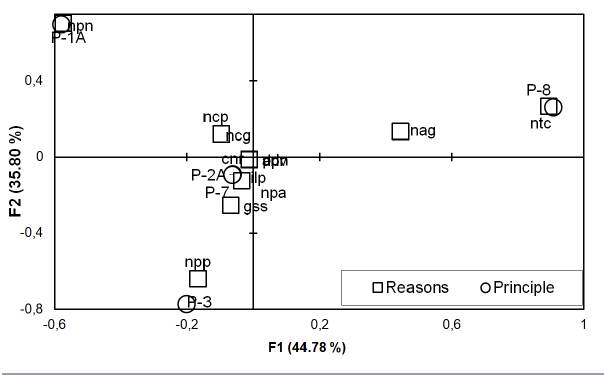
Fig. 2. Redundancy analysis biplot of the reasons for prioritizing each of the design principles, obtained through focus groups in Taganga. The x-axis (F1) accounts for 44.8% of the variance, and the y-axis (F2) accounts for 35.8%. See Tables 1 and 5 for